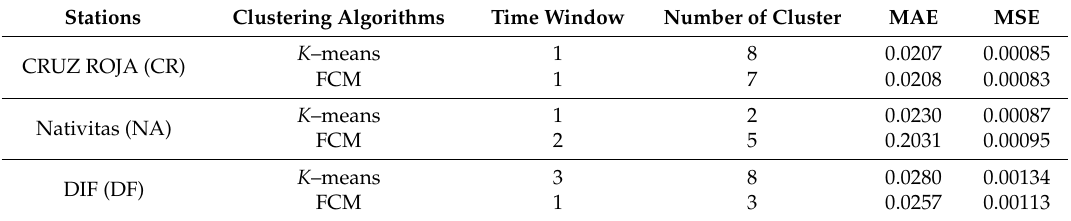
Table 17. Results for forecast of the average concentration of PM 10 for the next